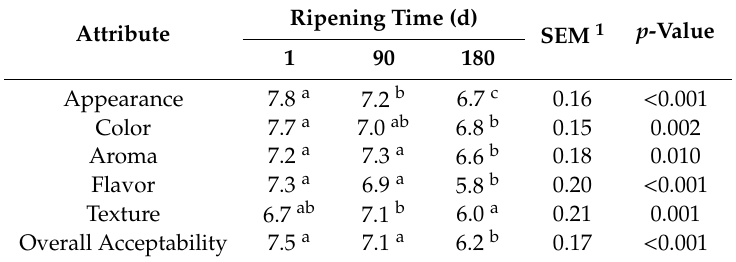
Table 4. Changes in the sensory properties of Mexican Manchego-style cheese made from hair sheep milk at di ff erent points of